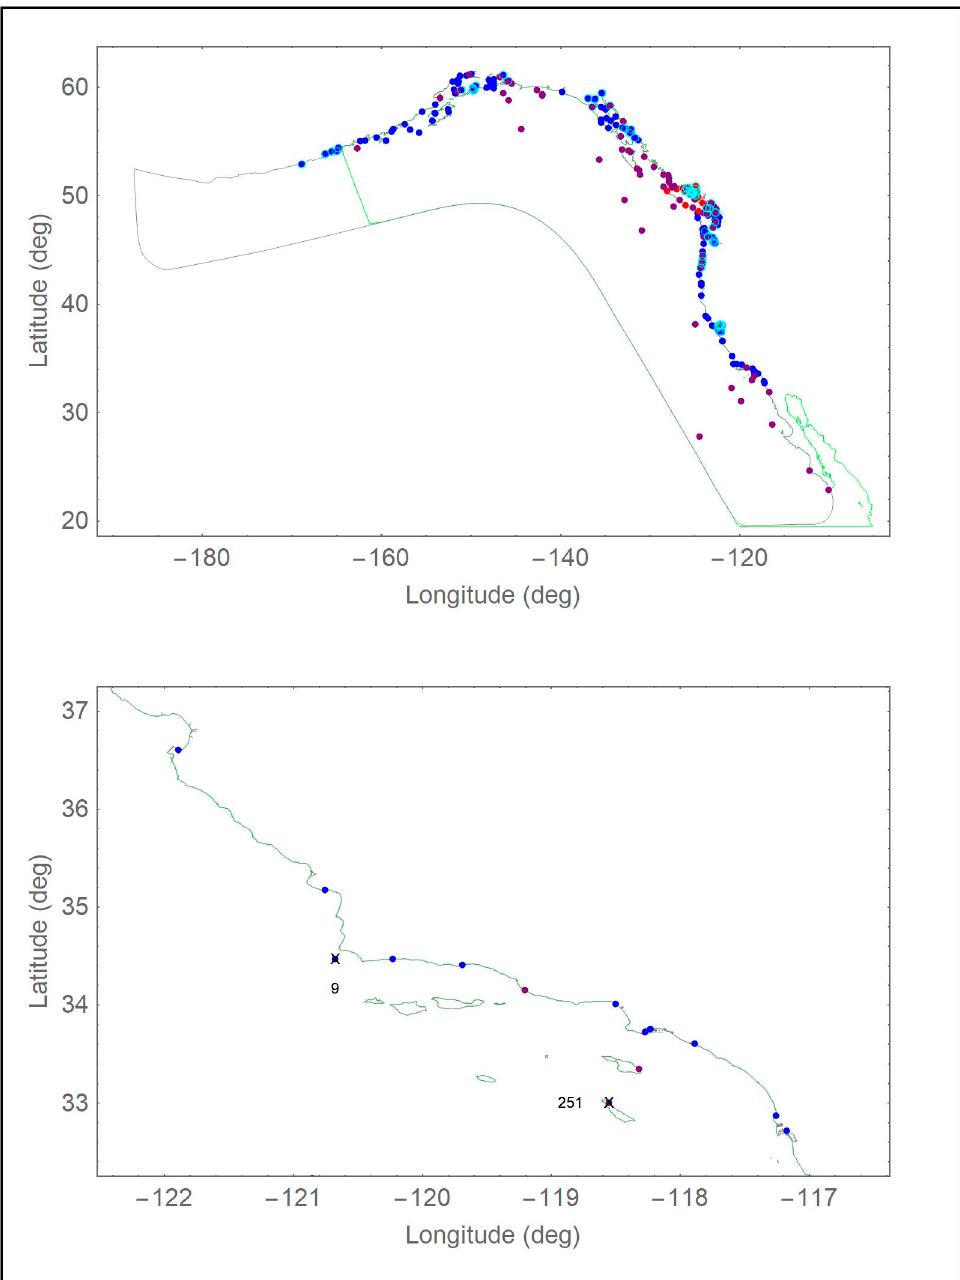
Figure A1. Location of validation stations: global and Southern California.